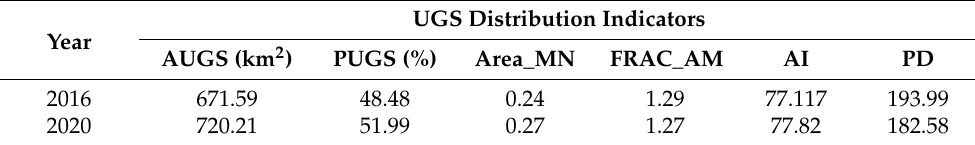
Table 5. Temporal changes in four types of urban green space distribution